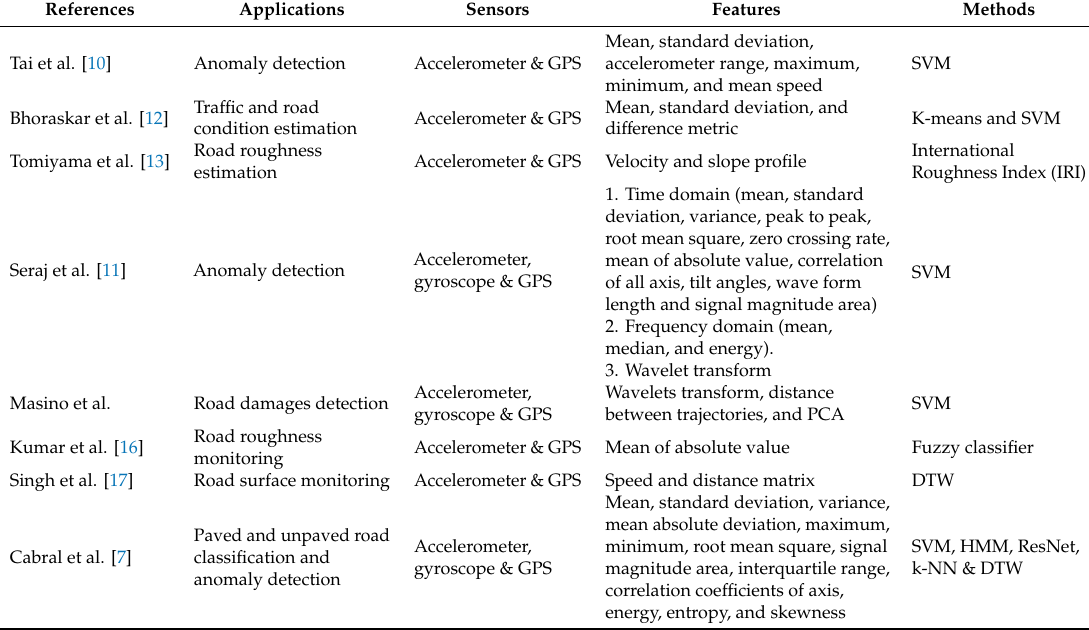
Table 1. Previous research on smartphone base in road surface